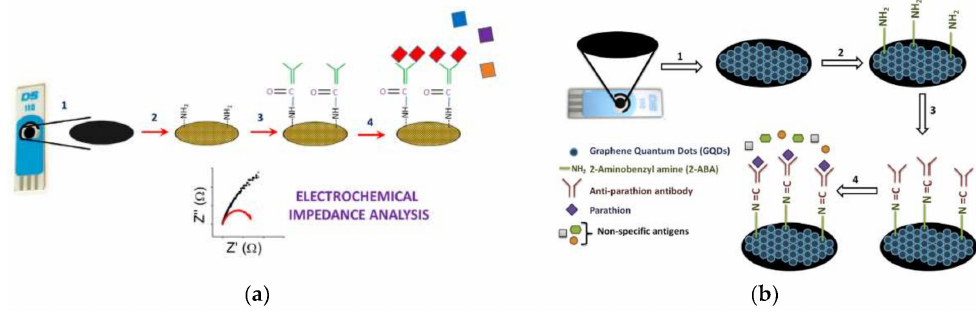
Figure 5. ( a ) Graphene modified screen-printed electrodes. ( b ) Graphene quantum dot modified SPE (reprinted with permission from